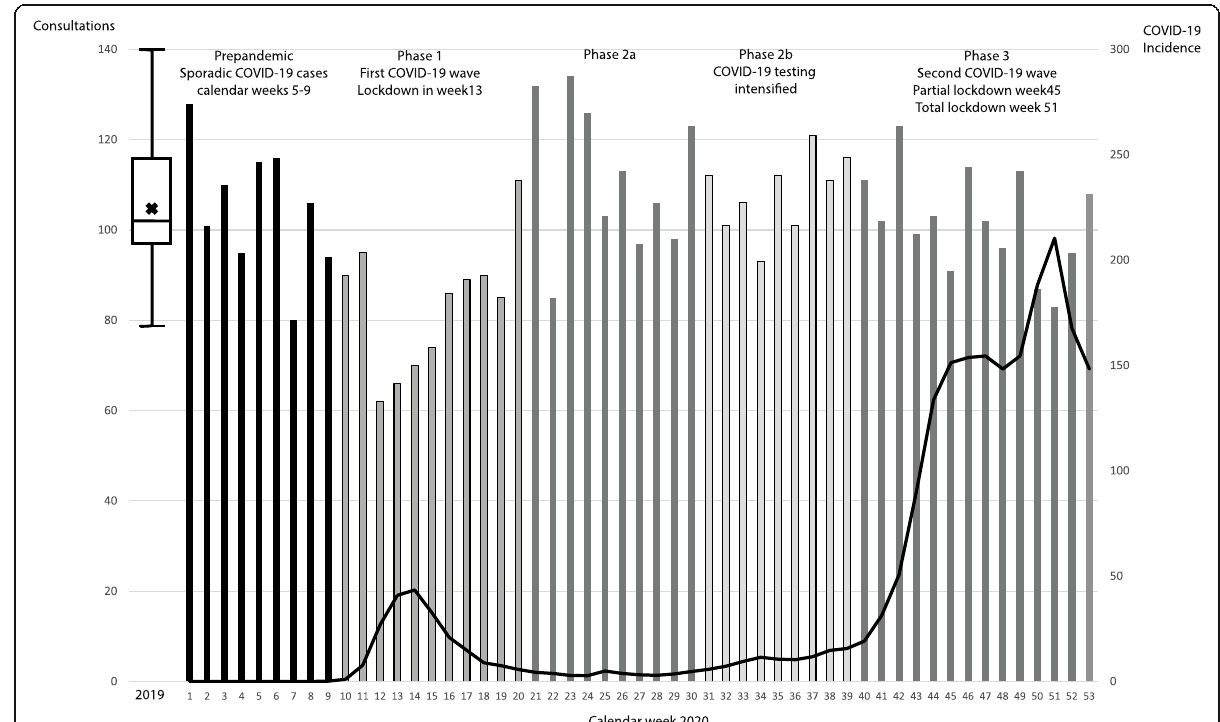
Fig. 1 Number of neuroradiological emergency consultations in a teleradiological network (bars) and 7-day incidence of notified SARS-CoV-2 infections* (line) by calendar week and pandemic lockdown phase in Germany, 2019 (boxplot) and calendar weeks 01 – 53/2020. *Source: Robert